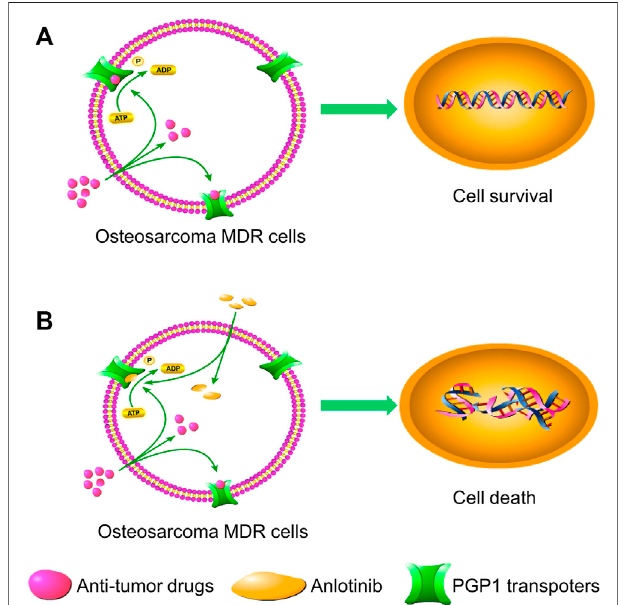
FIGURE 7 | Schematic diagram showing the MDR reversal effect of anlotinib. (A) . In the absence of anlotinib, PGP1 transporters utilize energy derived from ATP hydrolysis to extrude their substrate drugs across the membrane. (B) . However, when anlotinib is present, it may bind to the ATP-binding site of PGP1, thereby blocking the ef fl ux of substrate drugs through the transporter and increasing the intracellular accumulation of substrate drugs. Therefore, anlotinib can increase the intracellular concentration of substrate drugs in multidrug-resistant cells.